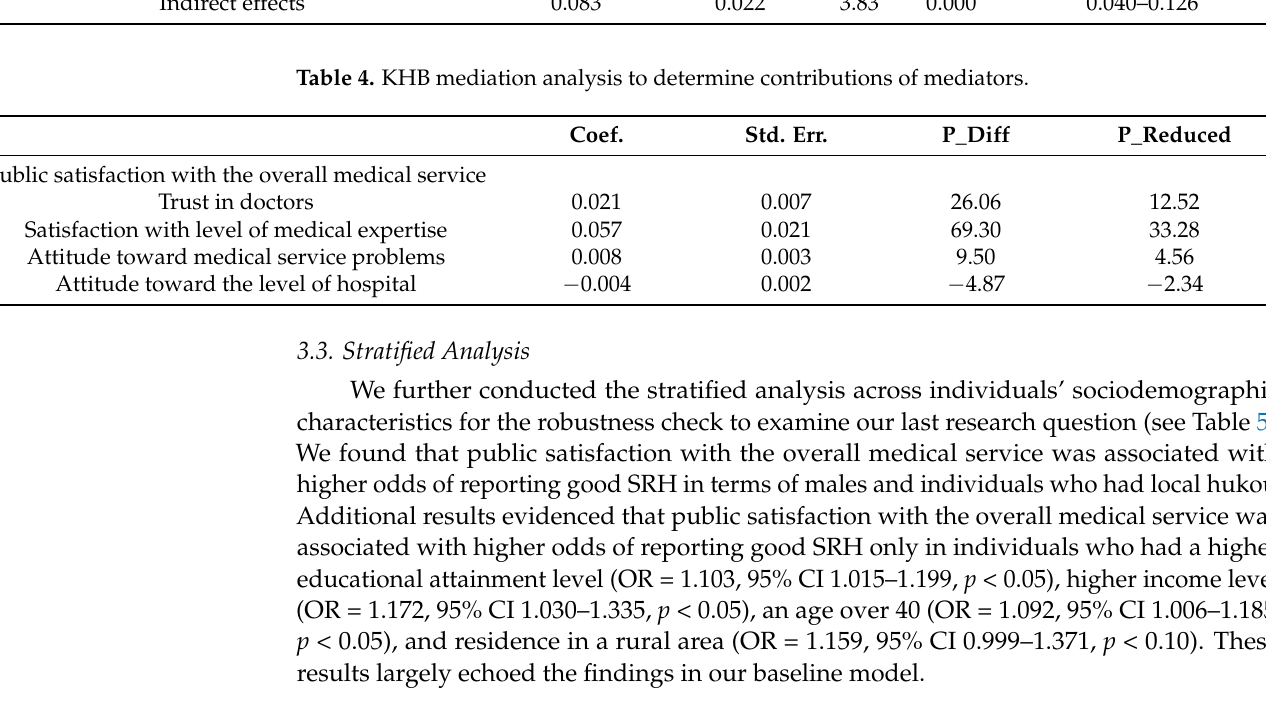
Table 5. Stratified analysis across individuals’ sociodemographic